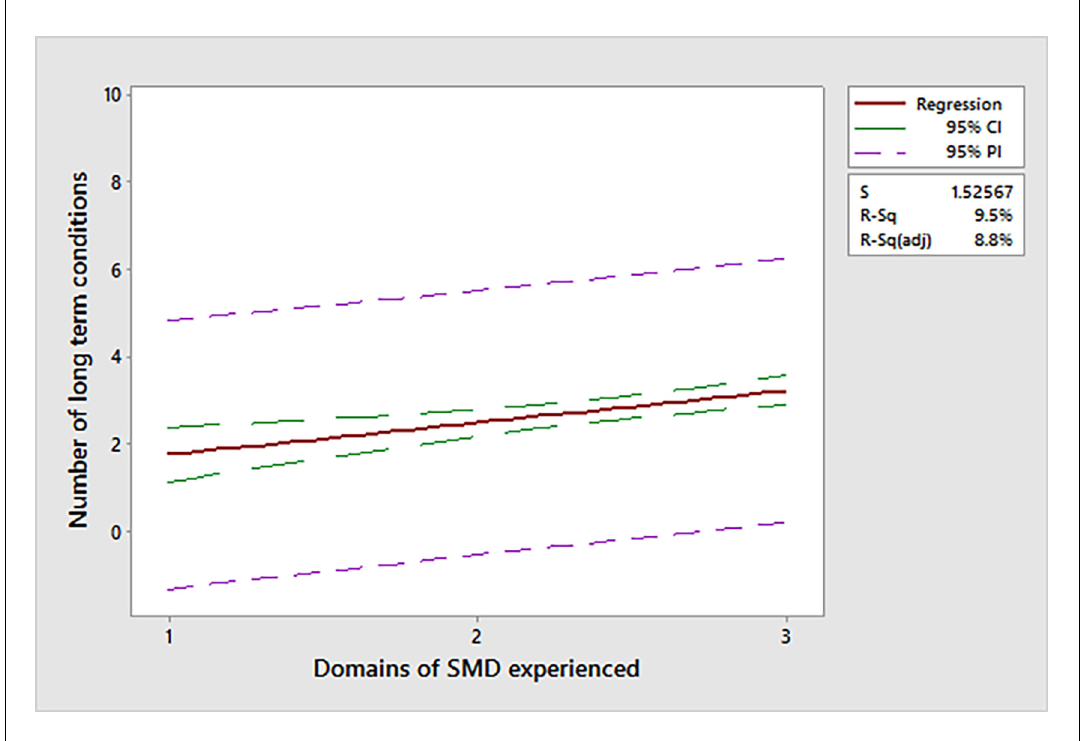
Figure 4. Relationship between domains of severe and multiple disadvantage experienced and long-term conditions. SMD = severe and multiple disadvantage. PI = prediction